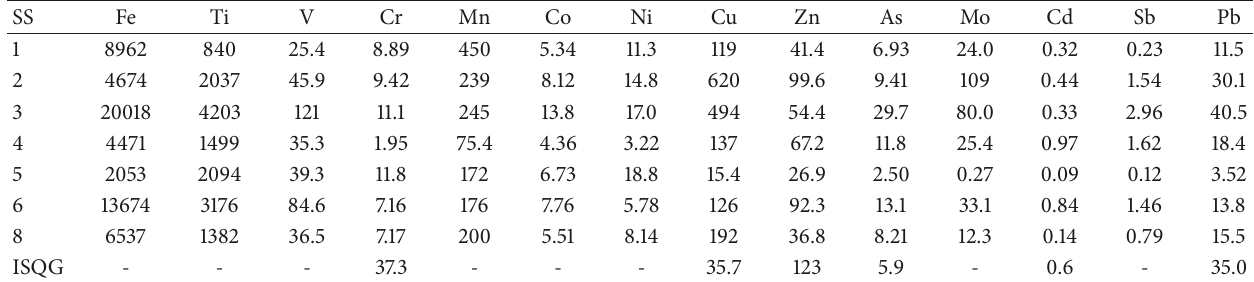
Table 5: Heavy metals in sediments (mean value in mg/kg) in the Voghji River basin in 2014–2016. SS Fe